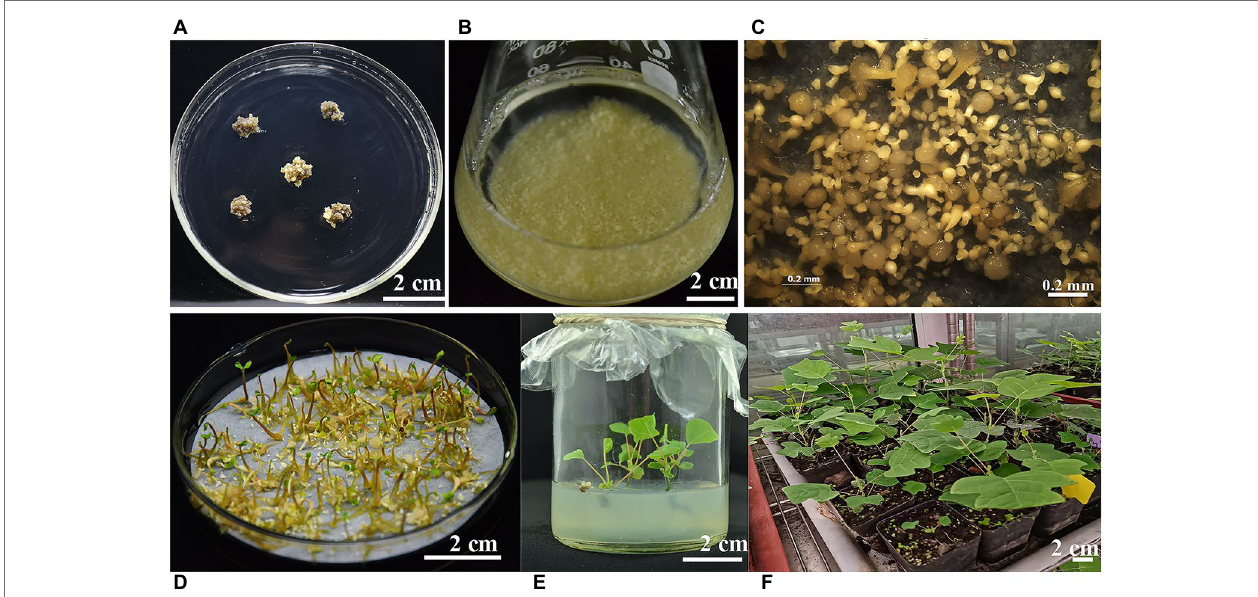
FIGURE 5 | The different developmental stages of transgenic plant regeneration from calli of the Liriodendron hybrid. (A) Geneticin (G418)-resistant embryogenic callus was cultured on callus selection medium (CSM). (B) Suspension culture embryogenic calli in liquid CSM. (C) Cotyledonary stage embryos were induced on embryo induction medium (EIM). (D) G418-resistant embryo seedlings. (E) Regenerating embryo seedlings were cultured on shoot elongation medium (SEM). (F) Regenerating transgenic plantlets growing in the greenhouse. (A,B,D,E,F) : scale bar = 2 cm; (C) : scale bar = 0.2